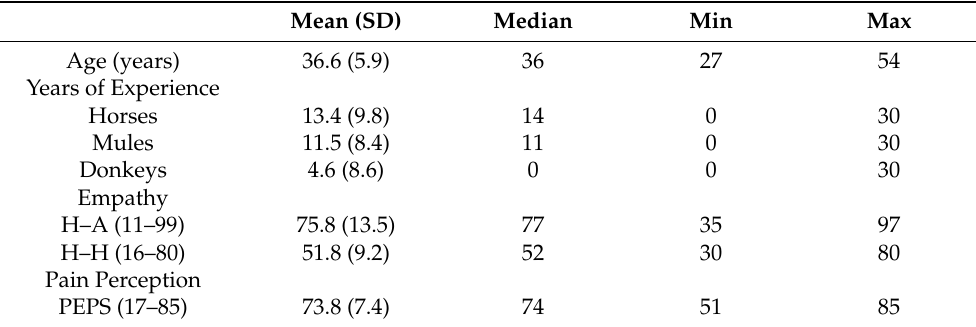
Table 2. Age and years of experience of soldiers working with horses, mules or donkeys ( n = 73). Levels of empathy and pain perception are also described here